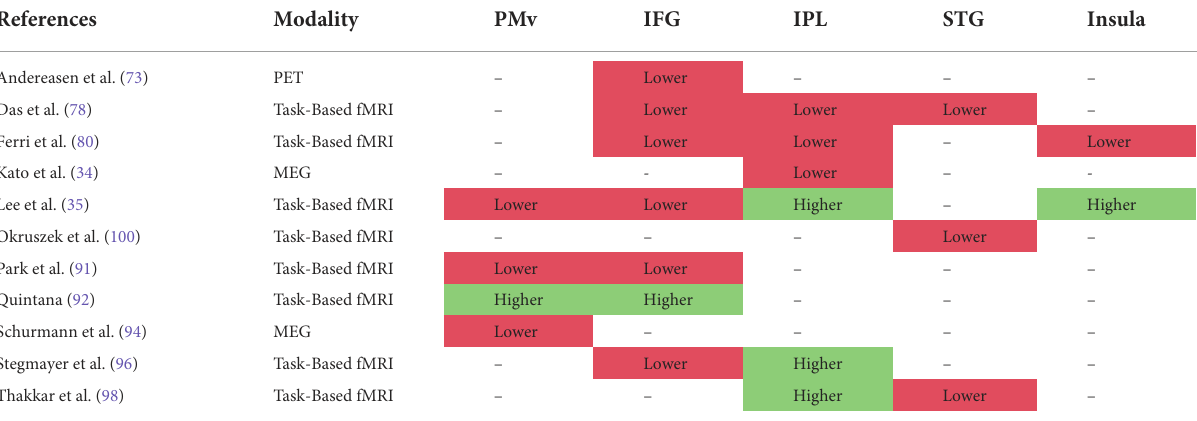
TABLE 2 The difference in the pattern of activation of different mirror neuron activity (MNA)-specific brain regions between schizophrenia and healthy control participants in task-based fMRI, MEG, and PET studies of MNA.